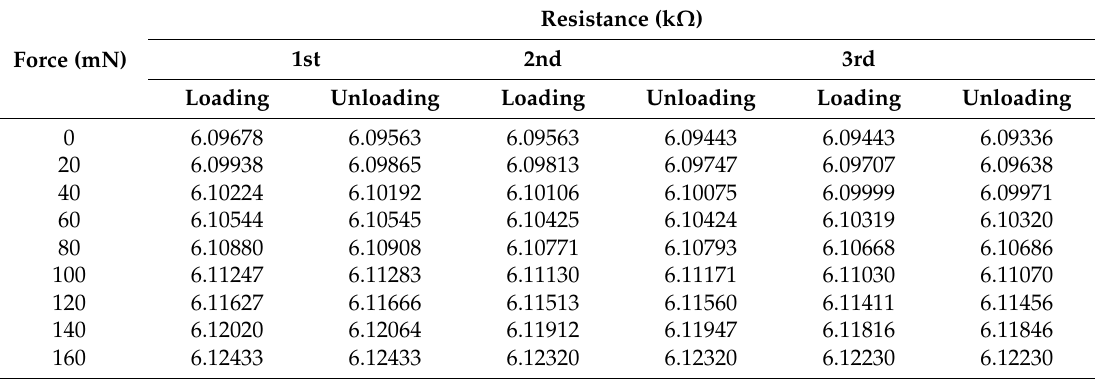
Table 4. The data of the static test.